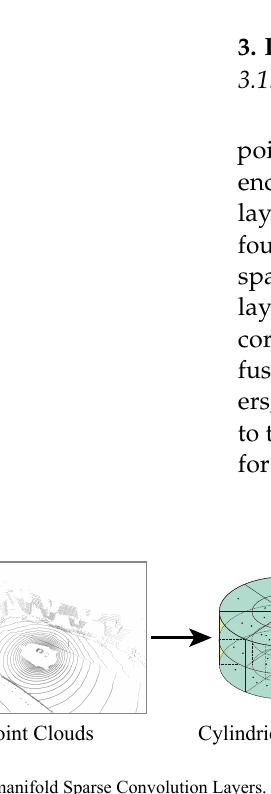
Figure 1. The network architecture overview of our SVASeg. LiDAR point clouds are firstly voxelized into cylindrical partitions as sparse features. Then, multiple submanifold sparse convoluation layers, sparse inverse convolution layers and a sparse multi-head attention module are used to process the sparse features and generate the point-wise semantic predictions. The voxel-based sparse multi-head attention is described in Section